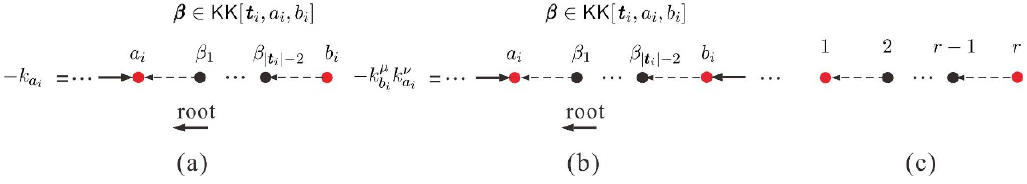
Figure 2 . The starting trace and an internal trace of a chain are respectively presented by the graphs (a) and (b). The trace 111 (cid:17) f 1 ; 2 ; : : : ; r g is expressed by the structure (c). In this paper, the two end nodes of a trace are always colored